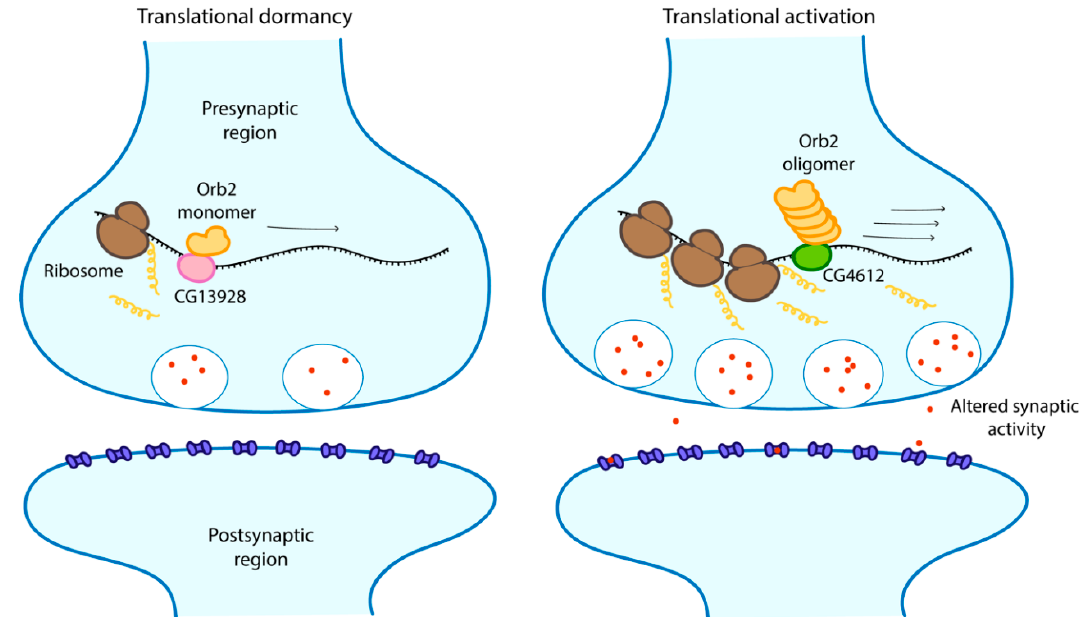
Figure 4. The repression and activation of mRNA translation by Orb2 monomer and oligomer respectively, resulting in altered synaptic activity and memory stabilisation. Scheme adapted from [99].